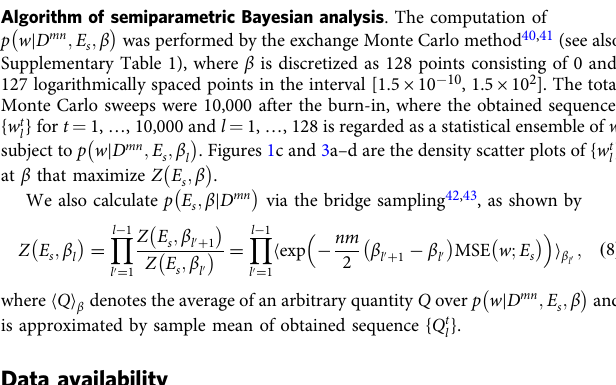
Algorithm of semiparametric Bayesian analysis . The computation of (cid:7) (cid:8) was performed by the exchange Monte Carlo method 40,41 (see also p w j D mn ; E s ; β Supplementary Table 1), where β is discretized as 128 points consisting of 0 and 127 logarithmically spaced points in the interval [1.5 × 10 − 10 , 1.5 ×10 2 ]. The